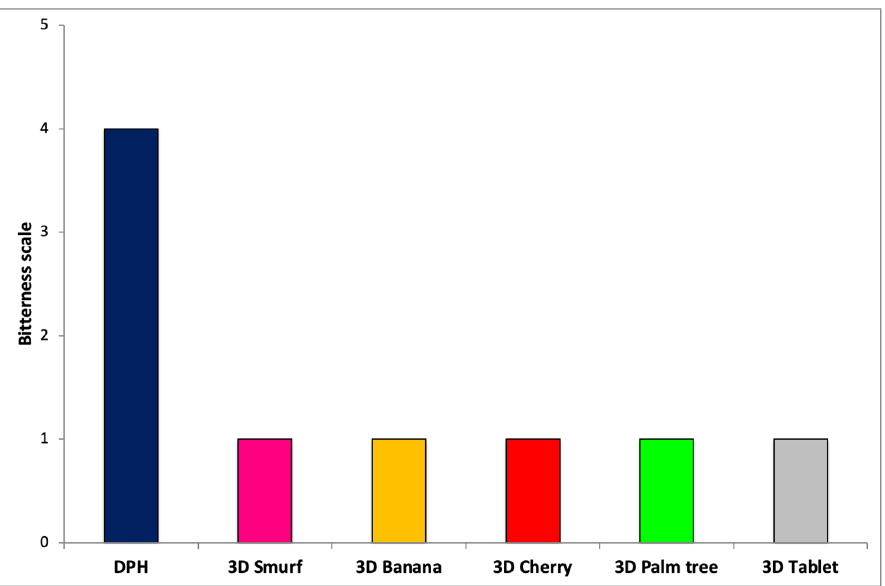
Figure 7. Taste masking evaluation of DPH and 3D printed fruit chews.